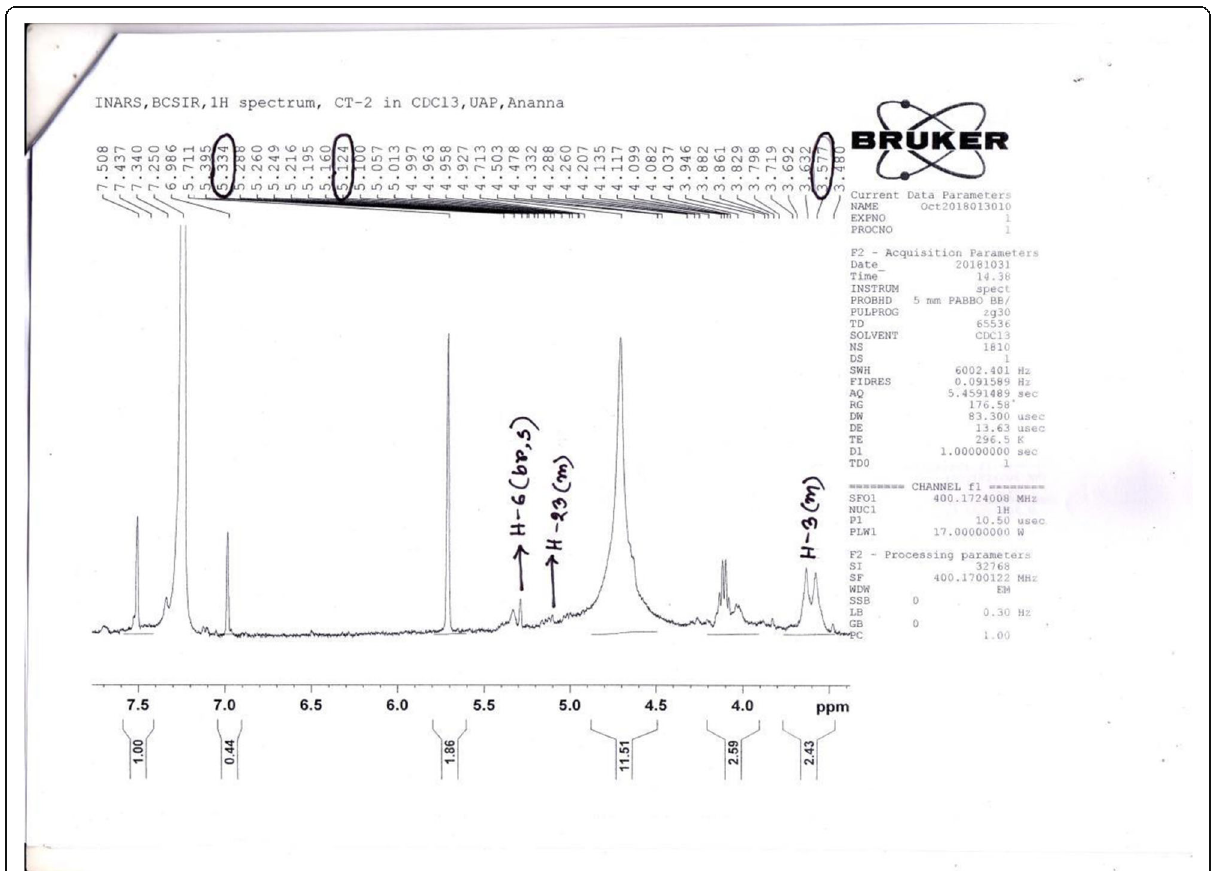
Membrane stabilizing activity